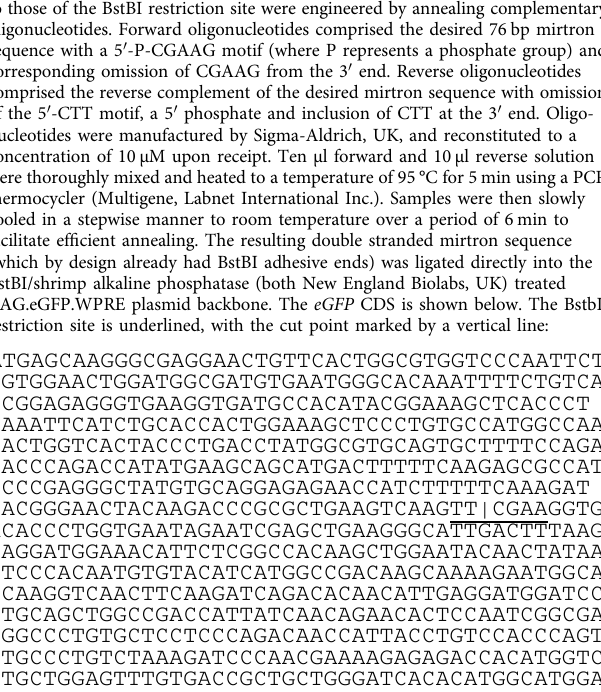
Cell culture and in vitro transfection . Human Embryonic Kidney 293 (HEK293) cells (#85120602, Culture Collections, Public Health England) were cultured in com- plete Dulbecco ’ s Modi fi ed Eagle Medium (complete DMEM) consisting of DMEM supplemented with 10% fi ltered foetal bovine serum, L-glutamine (2nM), penicillin (100U/ml), streptomycin (100 μ g/ml), 1% non-essential amino acids, and phenol red pH indicator (Gibco, Thermo Fisher Scienti fi c, UK). Prior to transfection, cells